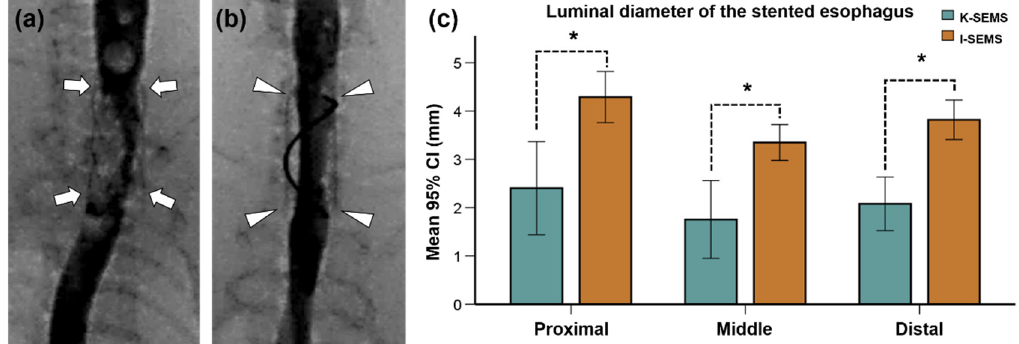
Figure 3. Esophagographic findings at 4 weeks after stent placement. Esophagographic images showing ( a ) severe luminal narrowing (arrows) in the K-SEMS group and ( b ) straight-line filling defect (arrowheads) in the I-SEMS group. ( c ) Graph showing the mean luminal diameter of the stented esophagus at 4 weeks after stent placement in both groups. K-SEMS, knitted self-expandable metallic stent; I-SEMS, interwoven self-expandable metallic stent; CI, confidence interval. * p <